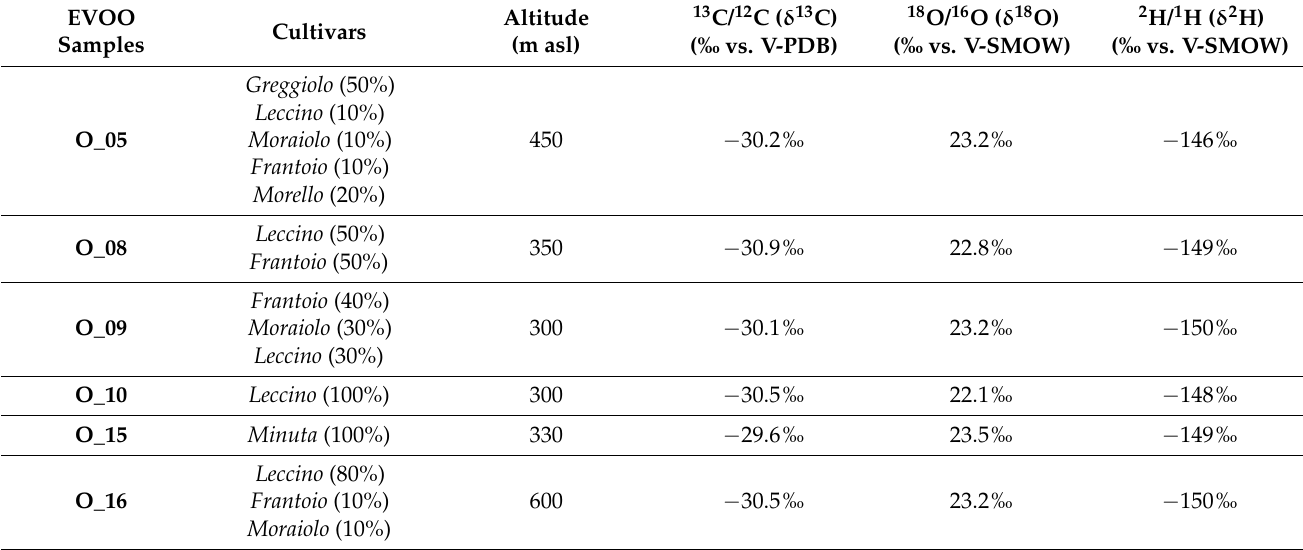
Table 2. Stable isotopic ratios of six EVOO samples.